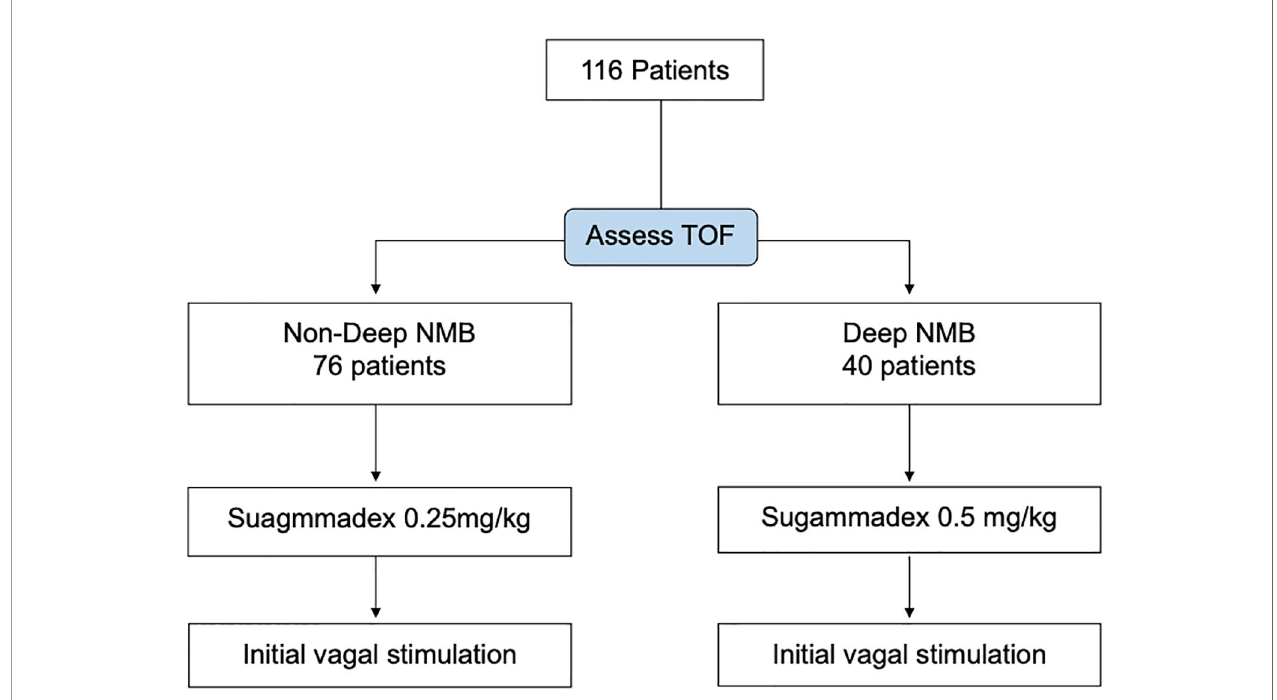
FIGURE 1 | Study fl owchart of the 116 consecutive patients, 40 with deep neuromuscular block (NMB) are reversed by sugammadex 0.5 mg/kg. Another 76 patients with moderate NMB or recovery are reversed by sugammadex 0.25 mg/kg. TOF, train of